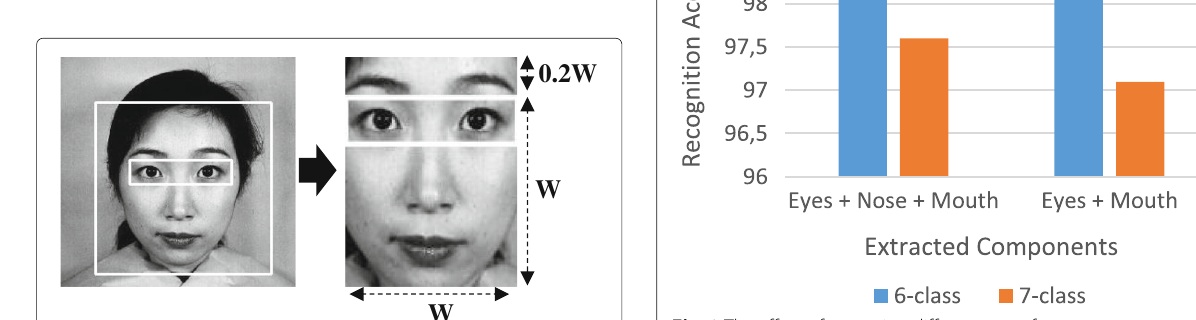
Fig. 9 The effect of extracting different sets of components on recognition accuracy in the CK+